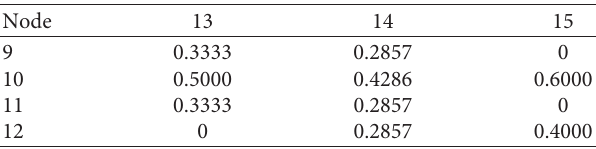
Table 5: Quality risk propagation coefficient matrix of the second- level to third-level nodes.